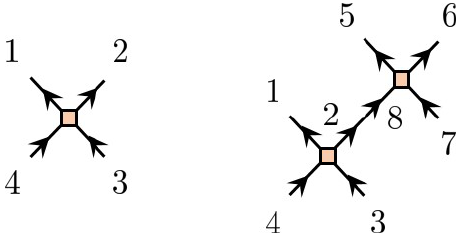
Figure 27 . Ordering of links in two simple geometries: one rank-four tensor and two rank-four tensors with a pair of links